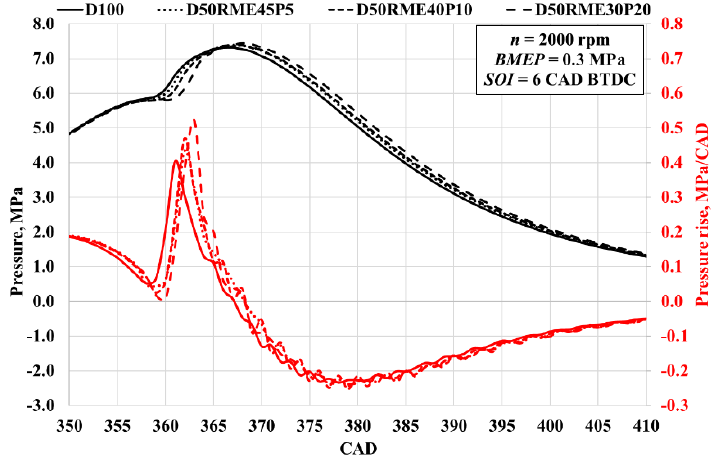
Figure 6. Dependence of pressure and pressure rise in the cylinder on the crank angle degree.